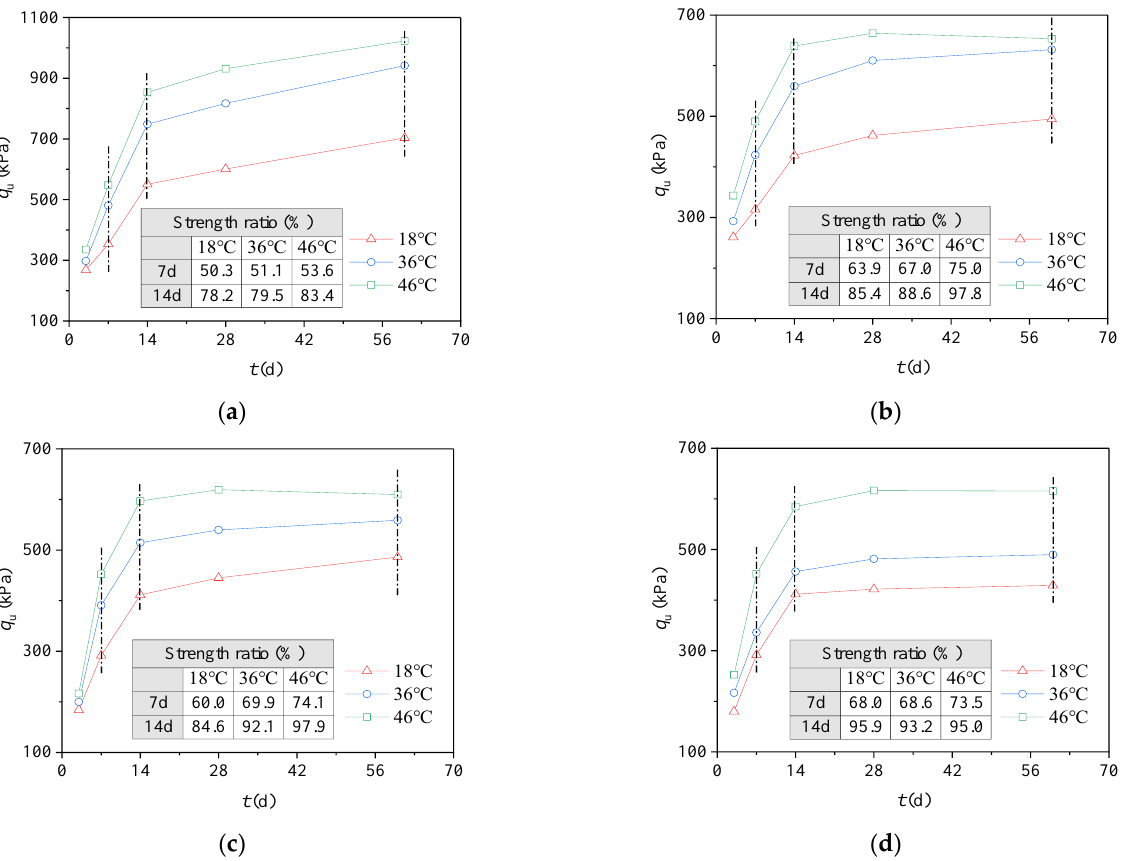
Figure 6. SEM images at different C HA (at a magnification of 20K): ( a ) C HA = 0%; ( b ) C HA = 4%; ( c ) C HA = 7%.